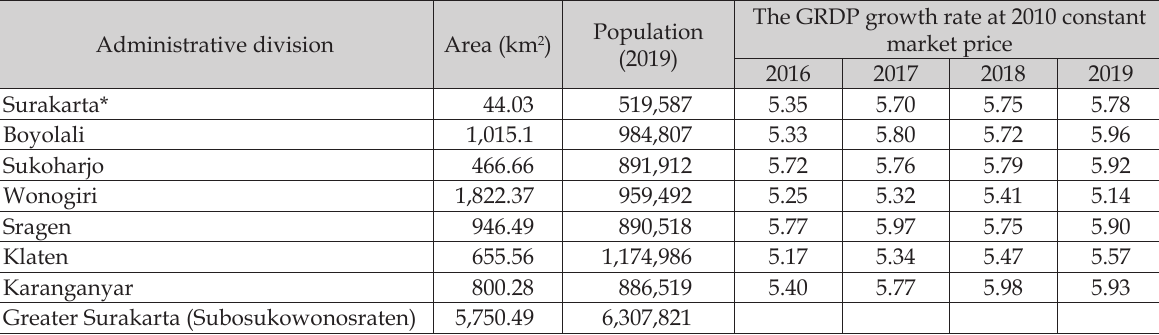
Table 1. The Subosukowonosraten or Greater Surakarta administrative area and GRDP Growth Rate (BPS-Sta - tistic of Central Java,